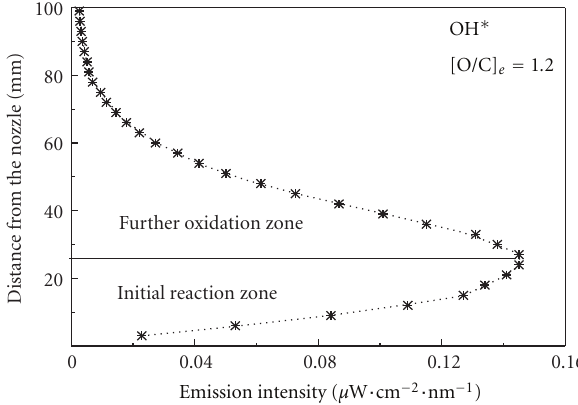
F 5: Two regions of the entire �ame separated by OH